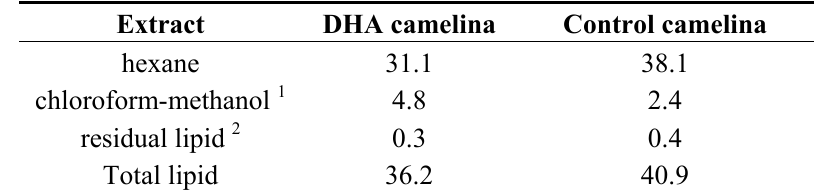
Table 1. Lipid content (as % of seed weight) of DHA- and control Camelina sativa seeds after hexane extraction, post hexane chloroform-methanol (CM) extraction and subsequent transmethylation of the extracted